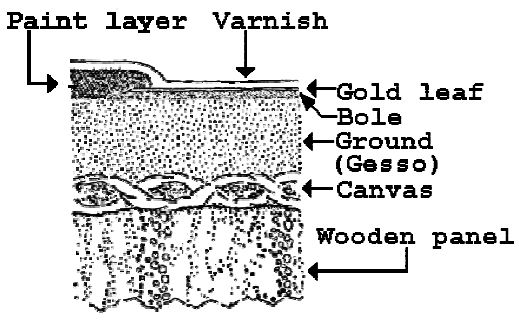
Fig. 16. Scheme of the structure of the icon.